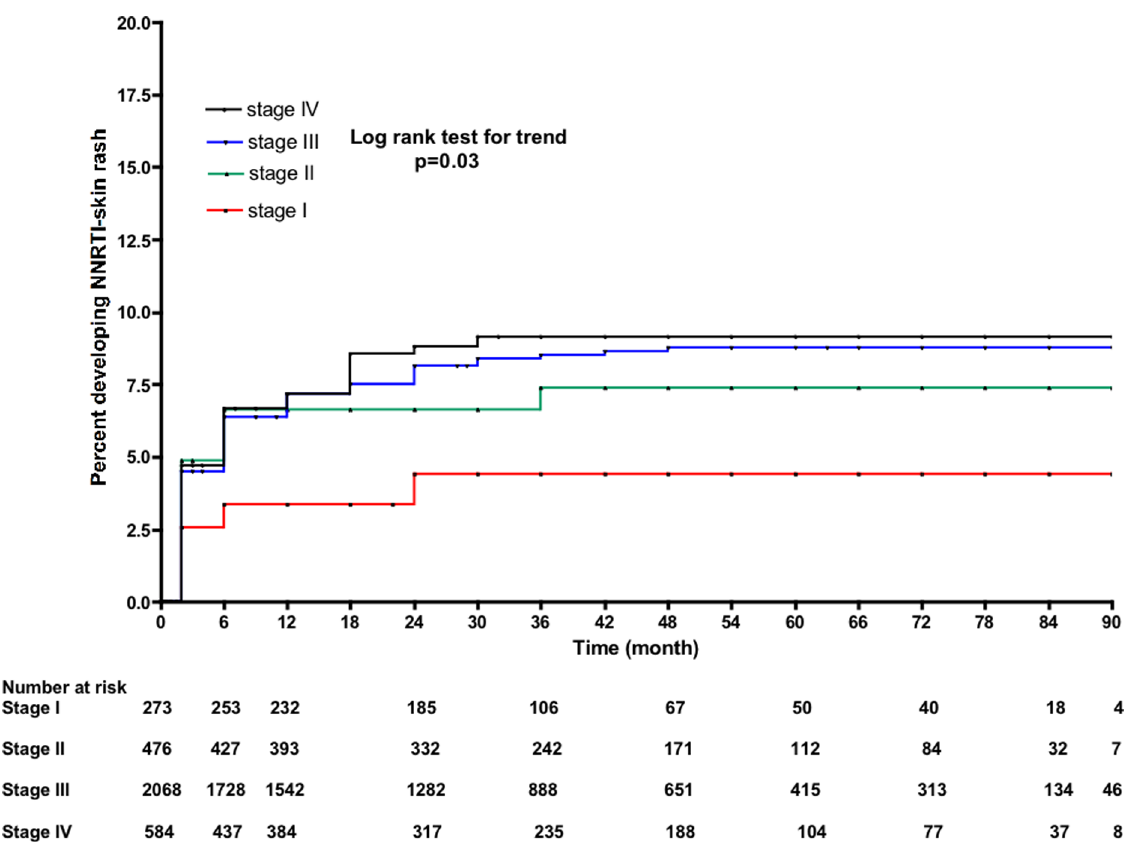
Figure 3. Kaplan-Meier estimates of risk for NNRTI-related skin rash according to WHO clinical stage at baseline.